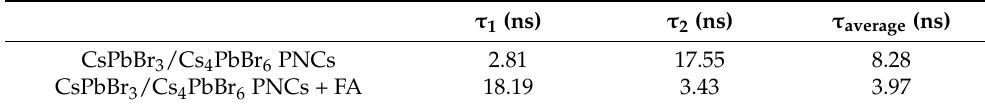
Table 3. Detection of FA in the actual samples.